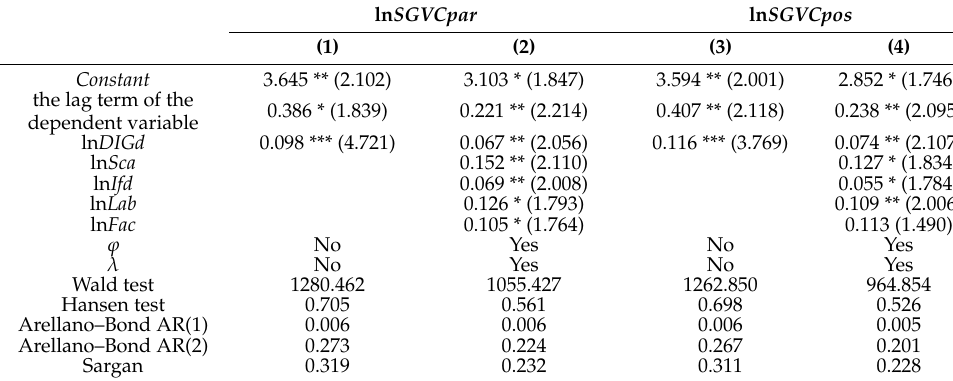
Table 2. Benchmark regression